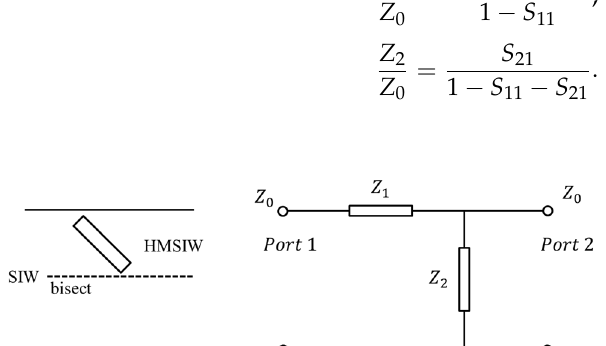
Figure 4. Configuration of the proposed HMSIW slot antenna (unit: mm).